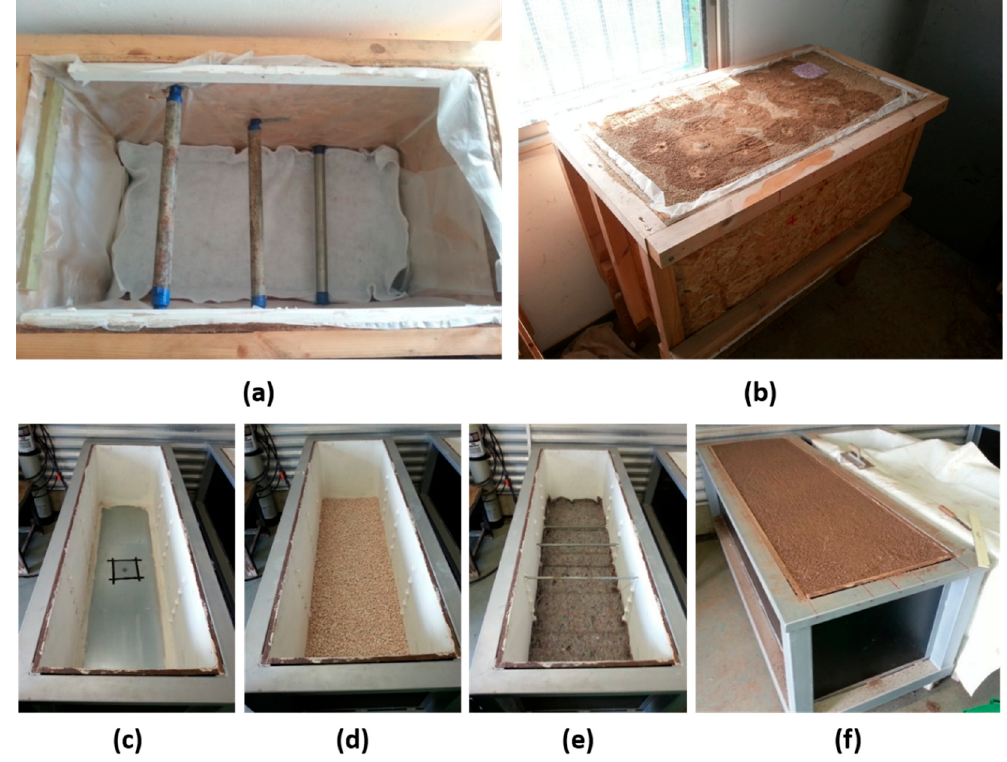
Figure 4. Small and large soil boxes for GPR laboratory irrigation experiments. ( a ) Empty small soil box; ( b ) small soil box filled with loess soil; ( c ) large soil box bottom, layer of netting; ( d ) layer of gravel; ( e ) layer of geotechnical fabric; ( f ) large soil box filled with grumusol soil. Much of the general GPR processing was adapted from high-level seismic data analysis